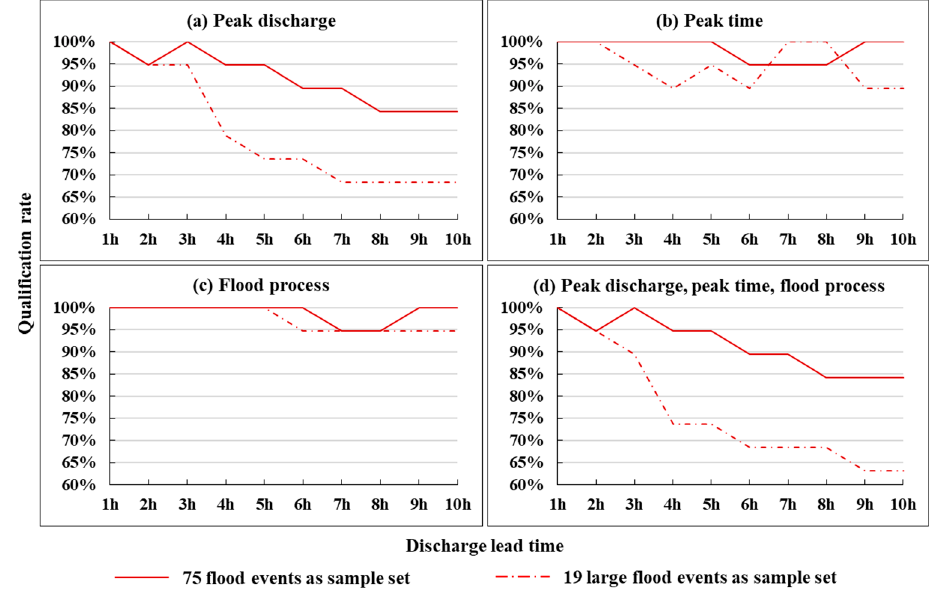
Figure 8. Qualification rate of large flood events by different sample sets.